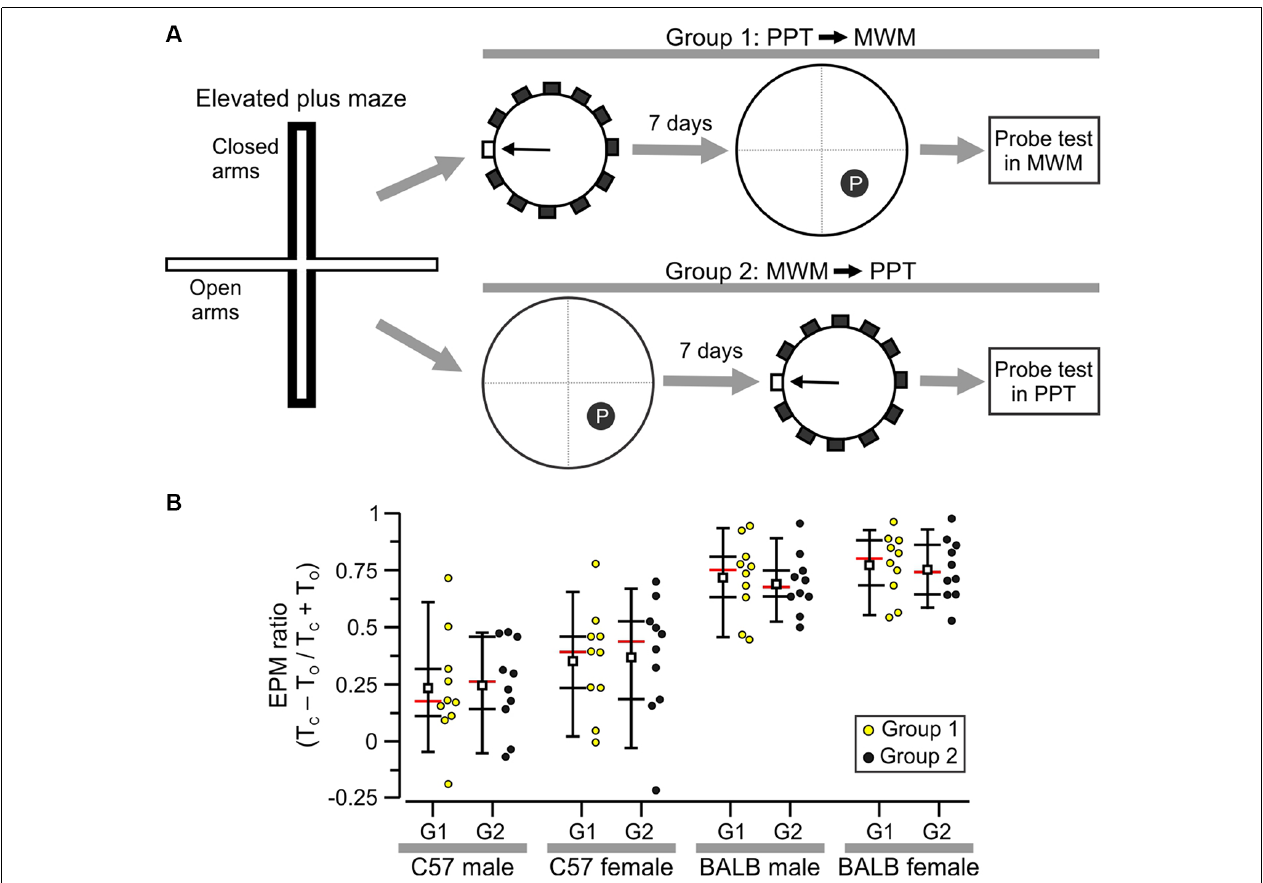
FIGURE 7 | Selection of subjects for a comparison of the PPT and Morris water maze (MWM). (A) Experimental design showing that all mice were first tested in the elevated plus maze (EPM) task and were then assigned to Group 1 (PPT followed by MWM) or Group 2 (MWM followed by PPT). (B) Plot of EPM ratios with each circle representing the value of an individual subject. These values were used to separate animals into Groups 1 and 2 for each sex/strain cohort. Abbreviations: T C , time in closed arms; T O , time in open